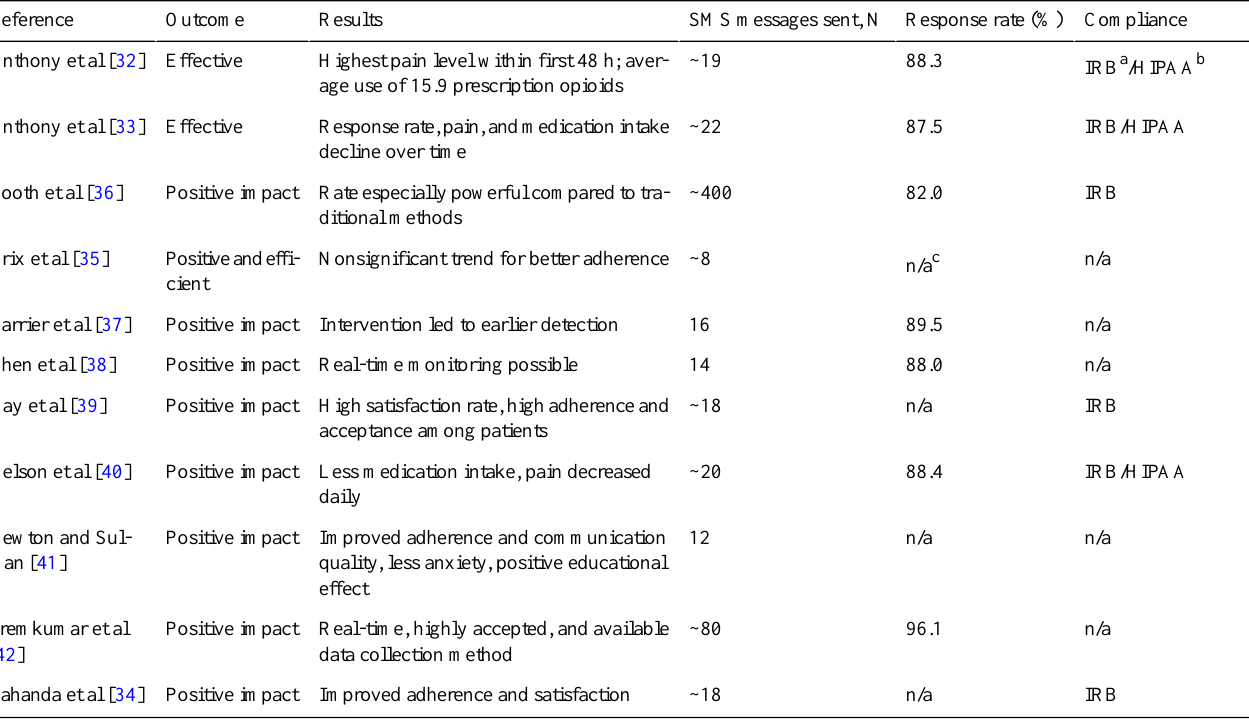
Table 3. Summary of systematic literature review